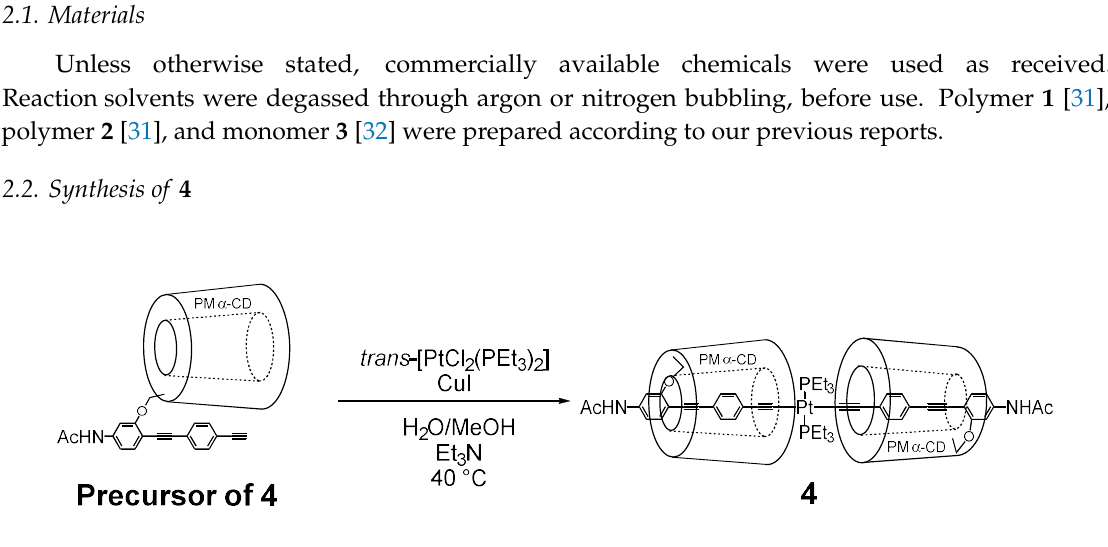
(Supplementary Figure S16). 31 P NMR (202 MHz, CDCl 3 , r.t.) : P = 10.83 (s and d, 1 J P-Pt 2369 Hz) (Supplementary Figure S17).